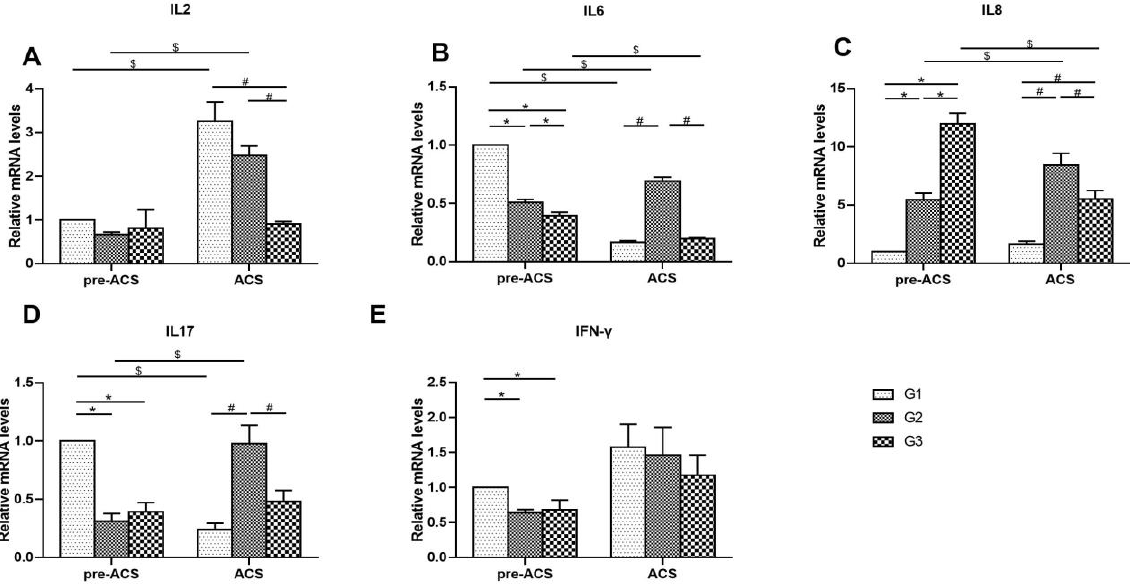
Figure 3. The mRNA levels of cytokines IL2 ( A ), IL6 ( B ), IL8 ( C ), IL17 ( D ), and IFN- γ ( E ) in ilea of broilers before and after ACS. Data were presented as mean ± SD ( n = 6). Different labels represent significant differences ( p < 0.05). pre-ACS (*), ACS (#) and before and after ACS ($). G1, cold stimulation for 0 h; G2, cold stimulation for 3 h; G3, cold stimulation for 6